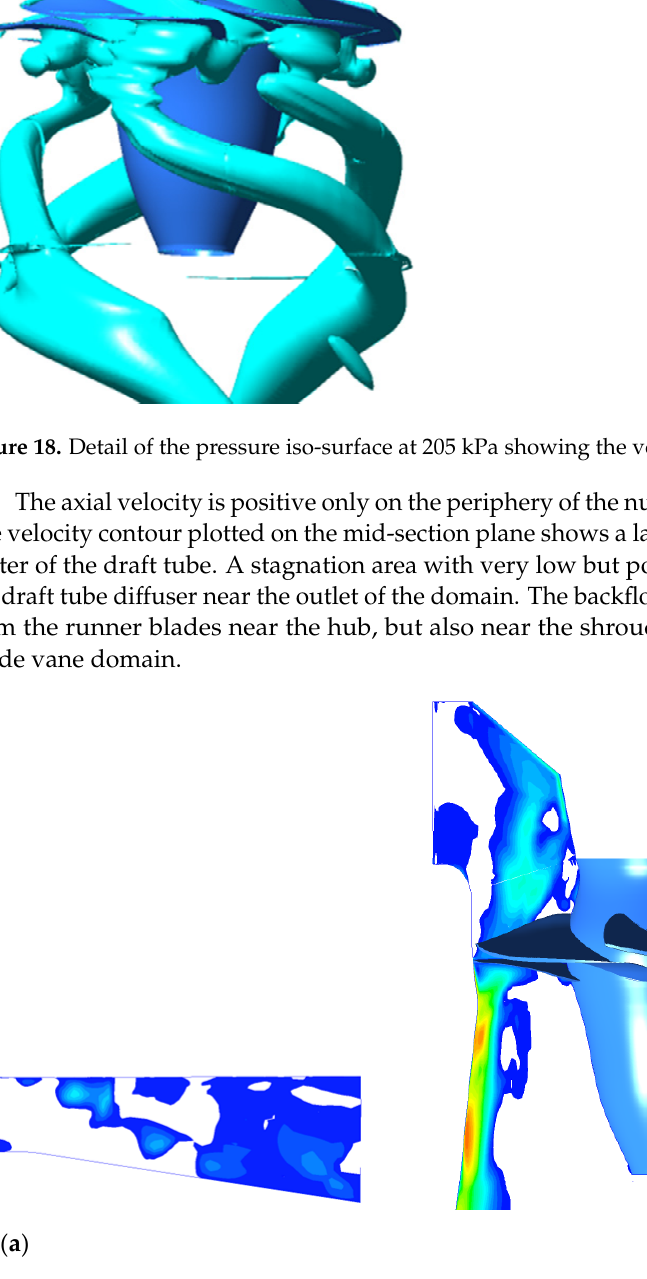
Figure 19. Contour plot of the liquid water axial velocity. ( a ) Complete computational domain. ( b ) Zoom on the runner domain.